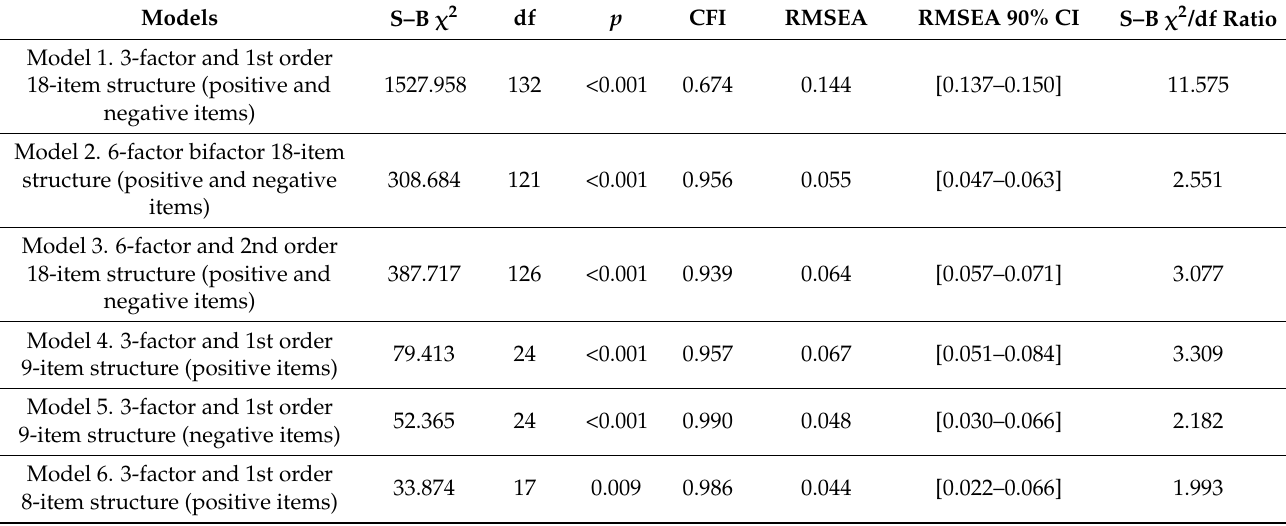
Figure 1. Model 1 and model 2. F. self = forgiveness of self; F. others = forgiveness of others; F. situations = forgiveness of situations; p = positively worded items; n = negatively worded items. Table 4. Goodness of fit indexes for the models assessed in the validity study.